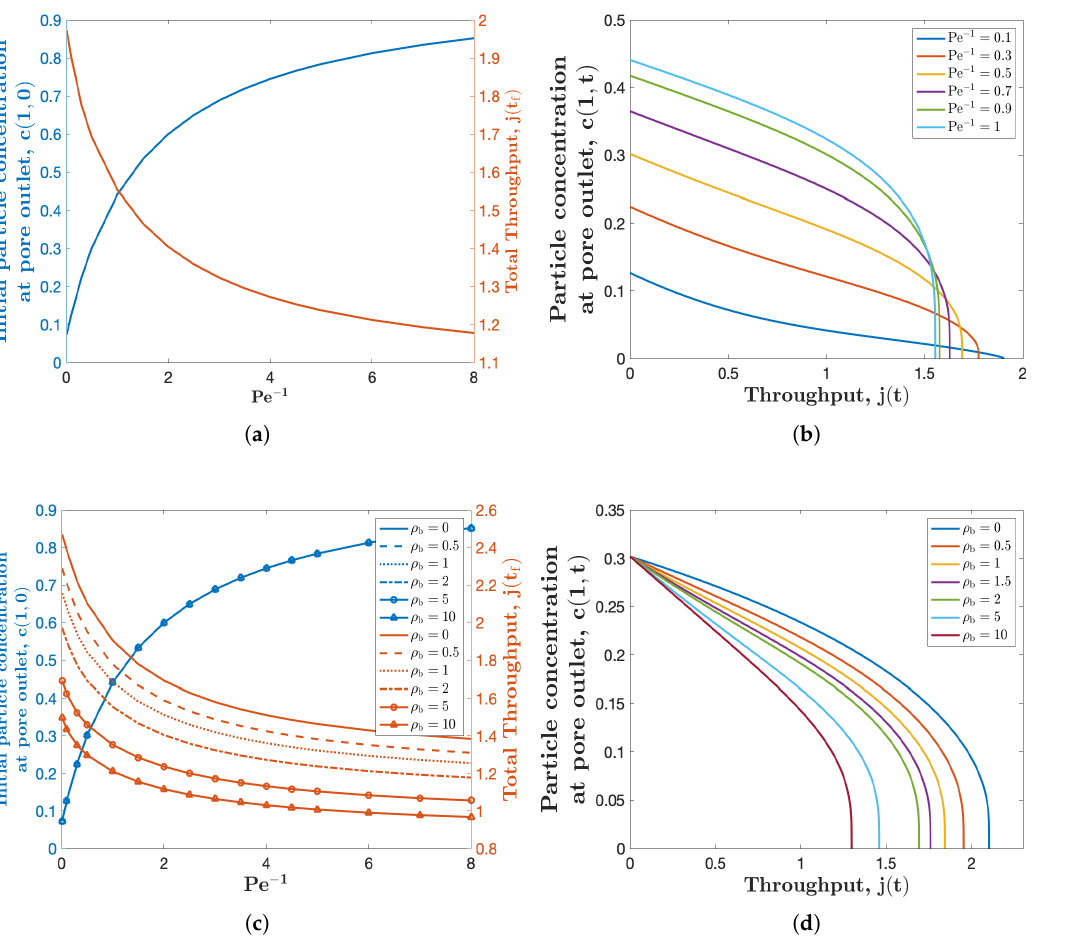
Figure 4. ( a ) Initial particle concentration at the membrane downstream c ( 1,0 ) and throughput j ( t ) versus the inverse of Péclet number Pe − 1 . ( b ) Particle concentration at the membrane downstream c ( 1, t ) versus throughput j ( t ) for several different values of Pe − 1 . Both simulations are for the uniform initial pore radius profile a ( x ,0 ) = 0.9, with β = 0.1, λ = 2 and ρ b = 2. ( c , d ) are similar to ( a , b ) respectively, for several different values of ρ b , while Pe − 1 = 0.5 in ( c